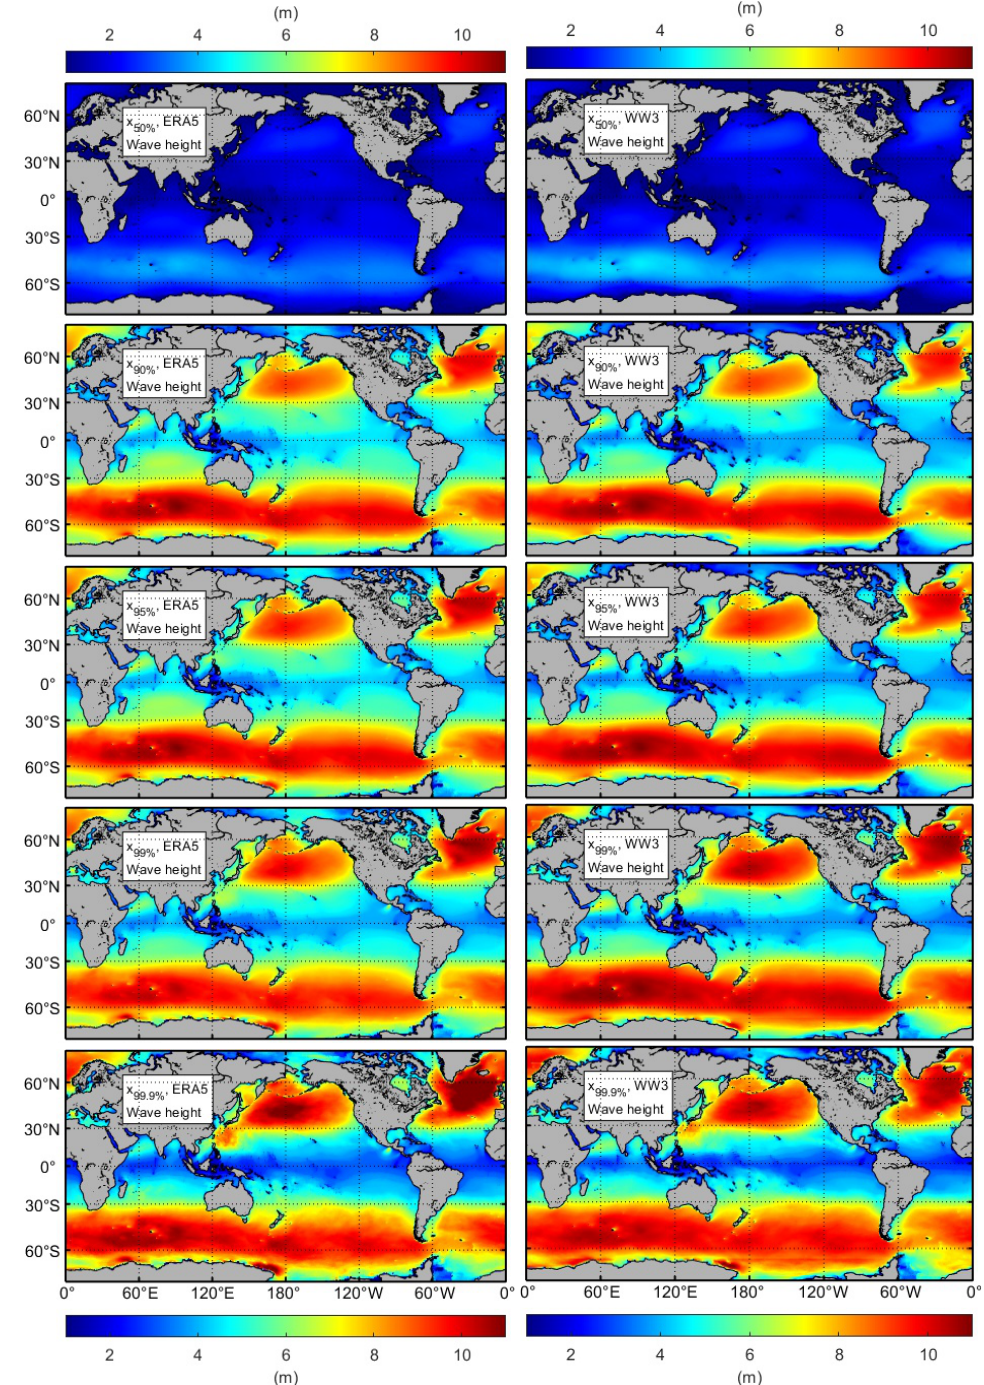
Figure 6. Mean annual fields of quantiles 50%, 90%, 95%, 99% and 99.9% of significant wave height ( left : ERA5, right :